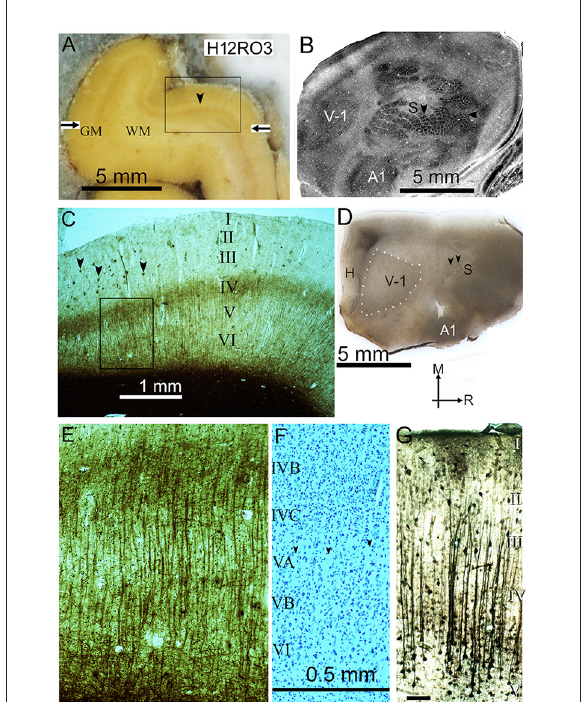
FIGURE1 (A) Frozen block of visual cortex from the third block of the right occipital lobe in the second human brain (H12RO3), on the microtome stage during sectioning. The gray matter (GM) contains more fixed blood than the paler white matter (WM) and the pale line that forms the stria of Gennari (arrowhead) defines the primary visual cortex. The borders of the primary visual area are marked by the horizontal arrows. The rectangular box indicates the position of the section shown in panel (C) . (B) Surface parallel section through the flattened rat neocortex stained for cytochrome oxidase activity. The section mainly passes through layer IV and sharp changes in the enzyme activity help to define the primary visual (V-1), primary somatosensory (S) and primary auditory (A1) areas. Within the somatosensory area there are distinct barrel-like structures that correspond to the input from individual whiskers (vertical arrowhead) or guard hairs (horizontal arrowhead) as described previously (Wallace, 1987). (C) Myelin-stained section from the position indicated in panel (A) , showing the stria of Gennari in the middle of layer IV. There are small pathological clumps of stained material in the outer layers (marked by arrowheads) that correspond to beta amyloid plaques but they are not present in significant numbers in the deep layers. The rectangular box shows the position of the image shown at higher power in panel (E) . (D) Flattened tangential section of rat cortex stained for myelin. This shows the location of the three main sensory areas as well as the hippocampus (H). The section passes through layer IV of the primary visual (V-1) and posterior somatosensory (S) areas and obliquely through the primary auditory area (A1) at the lateral edge of the block. The primary visual area is outlined by white dots while the two black arrow heads indicate the position of whisker barrels. The arrows indicate the medial (M) and rostral (R) directions. (E) Higher power view of the part of the section indicated in panel (C) that shows the parallel bundles of myelinated fibers that are characteristic of the deep layers of the primary visual cortex. (F) Corresponding area of a nearby section stained for Nissl substance. There is some evidence